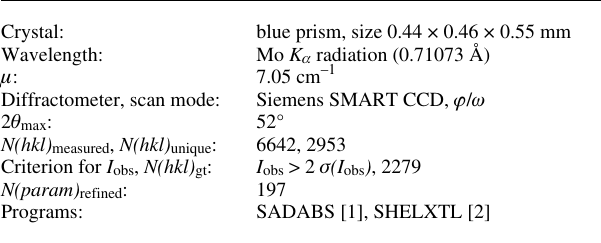
Table 1. Data collection and